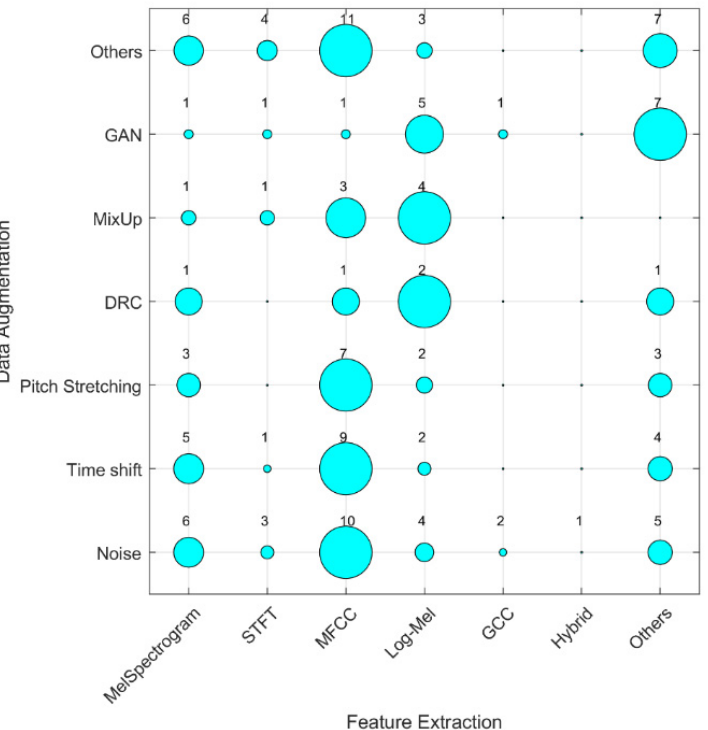
Figure 13. Bubble plot of publications by feature extraction and data augmentation methods. The size of a bubble is proportional to the number of published publications (given above the bubble) and bubble coordinates correspond to the feature extraction and data augmentation methods used.